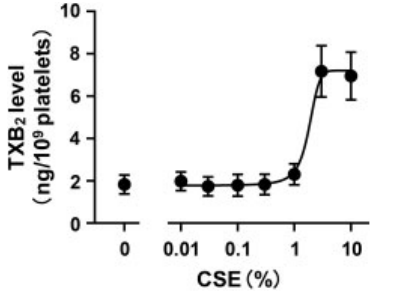
Fig. 5 Potentiatingeffectsofcigarettesmokeextract(CSE)onTXsynthase activity in platelets. To estimate the TX synthase activity in platelets, we added PGH 2 to platelets and measured the content of TXB 2 , a stable TXA 2 metabolite. PGH 2 (10 nM) was added to washed platelets to induce TXA 2 production and incubated for 5 minutes. CSE was added at the indicated concentration to washed platelets 5 minutes before the addition of PGH 2 . Each value is the mean (cid:1) SEM, n ¼